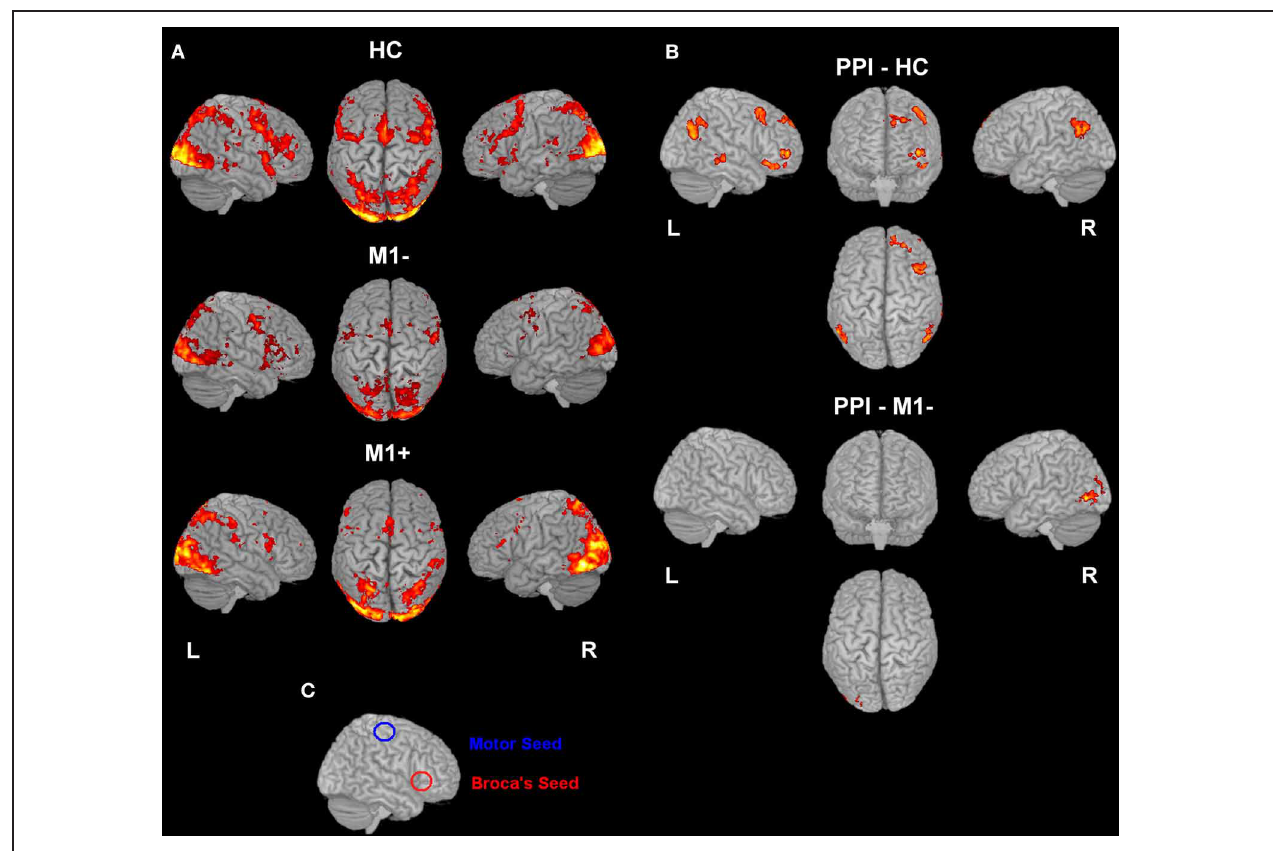
significant increases of connectivity to the left Broca’s area during verb generation task for healthy controls and for M1 − are shown. For M1 + PPI analysis didn’t find any area with a significant activation. (C) Overlapping of the seed regions (Broca’s and M1 area) on a rendered 3D